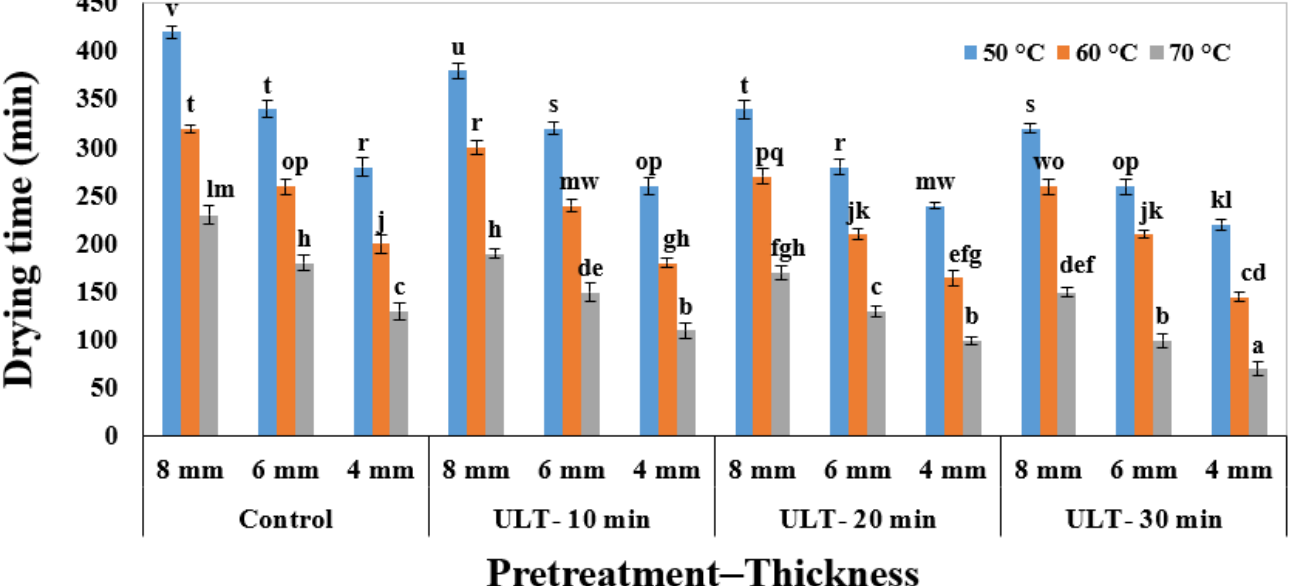
Figure 1. Drying time under different conditions for drying kiwifruit slices.